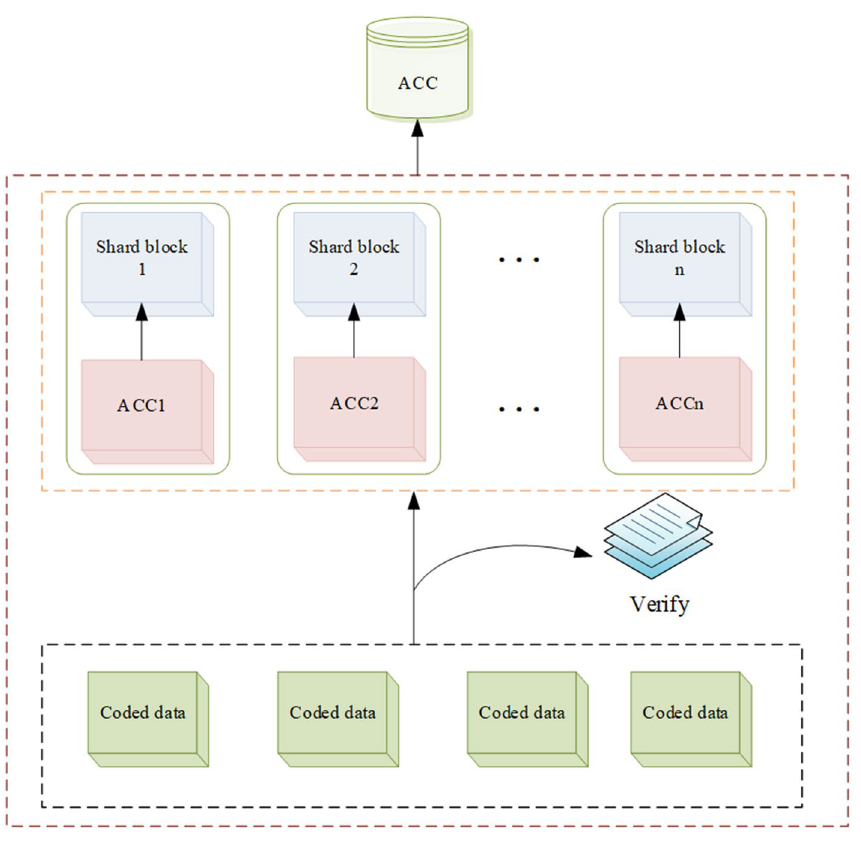
Figure 3. Coded sharding blockchain storage scheme based on bilinear accumulator.